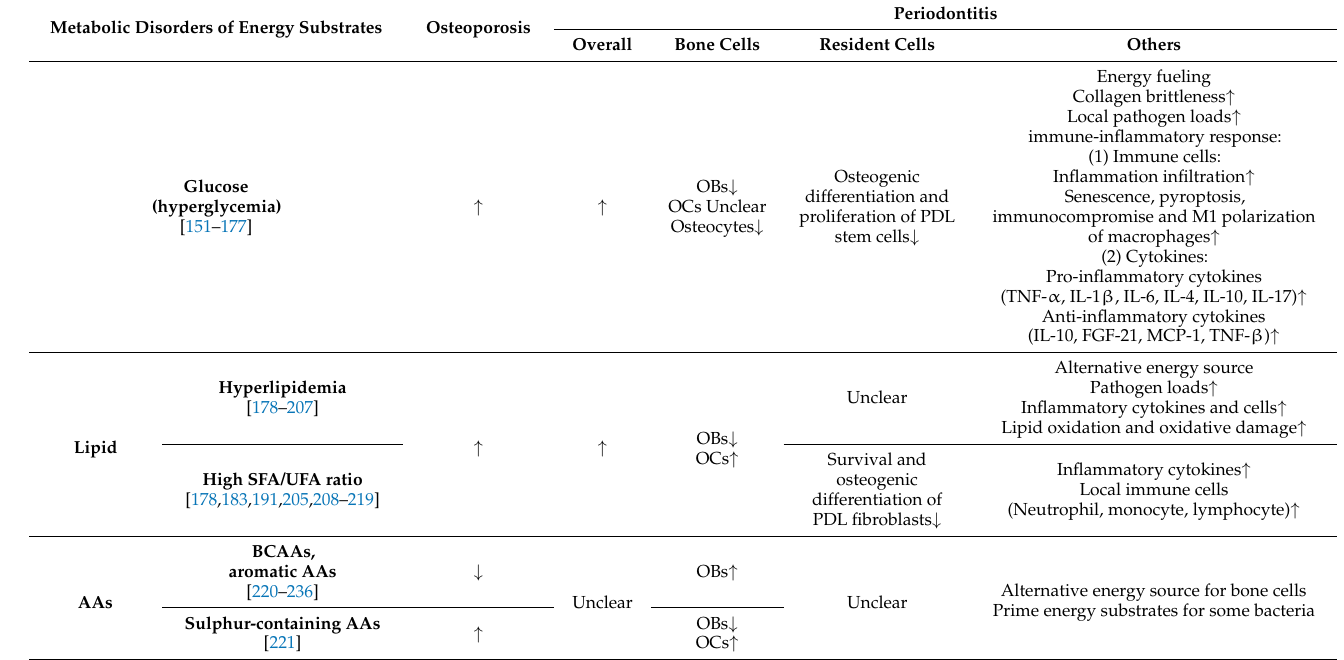
Table 2. Impact of metabolic disorders of energy substrates on osteoporosis and